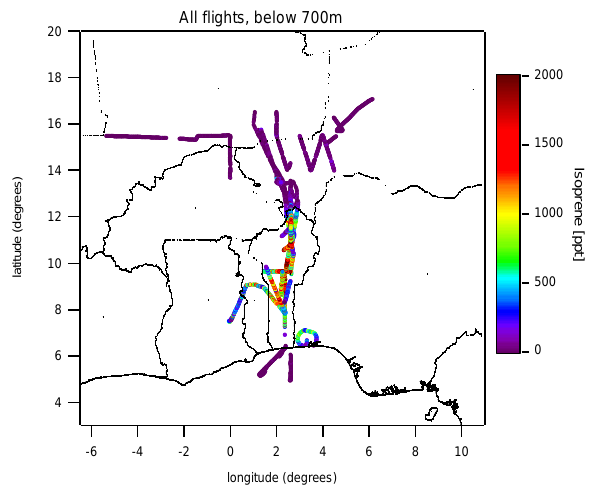
Figure 1 - FAAM BAe-146 aircraft flight tracks coloured by isoprene concentrations measured below 700m during the AMMA field campaign in July and August 2006.